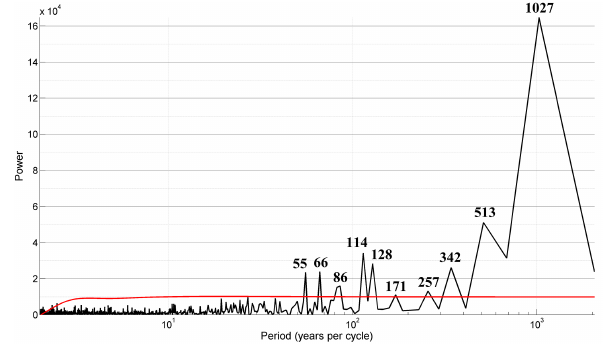
Figure 8. Fourier analysis for the JJA temperature reconstruction. Red line shows power spectrum of red noise with lag 1 autocorrela- tion estimated from the series. Period: 8 BC–AD